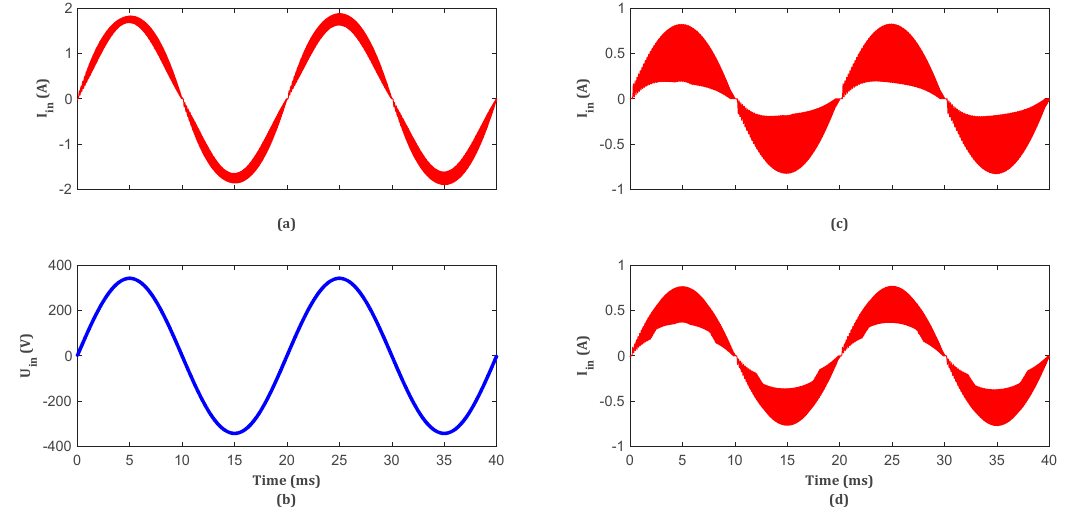
Figure 15. Simulated input current ( a ) and voltage ( b ) at P = 200 W; ( c ) input current at P = 50 W ( γ = 0.25 and f = 64 kHz); ( d ) input current at P = 50 W ( γ = 0.37 and f = 150 kHz).